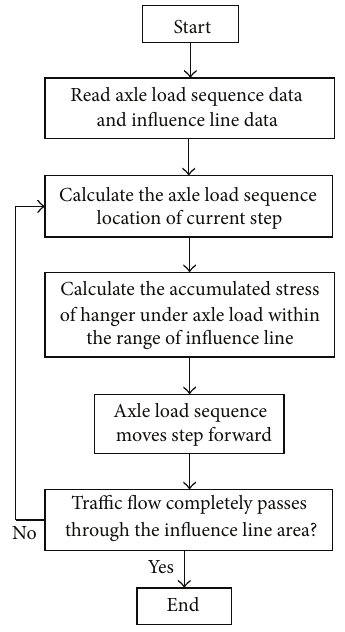
Figure 12: Flowchart showing calculation of suspender